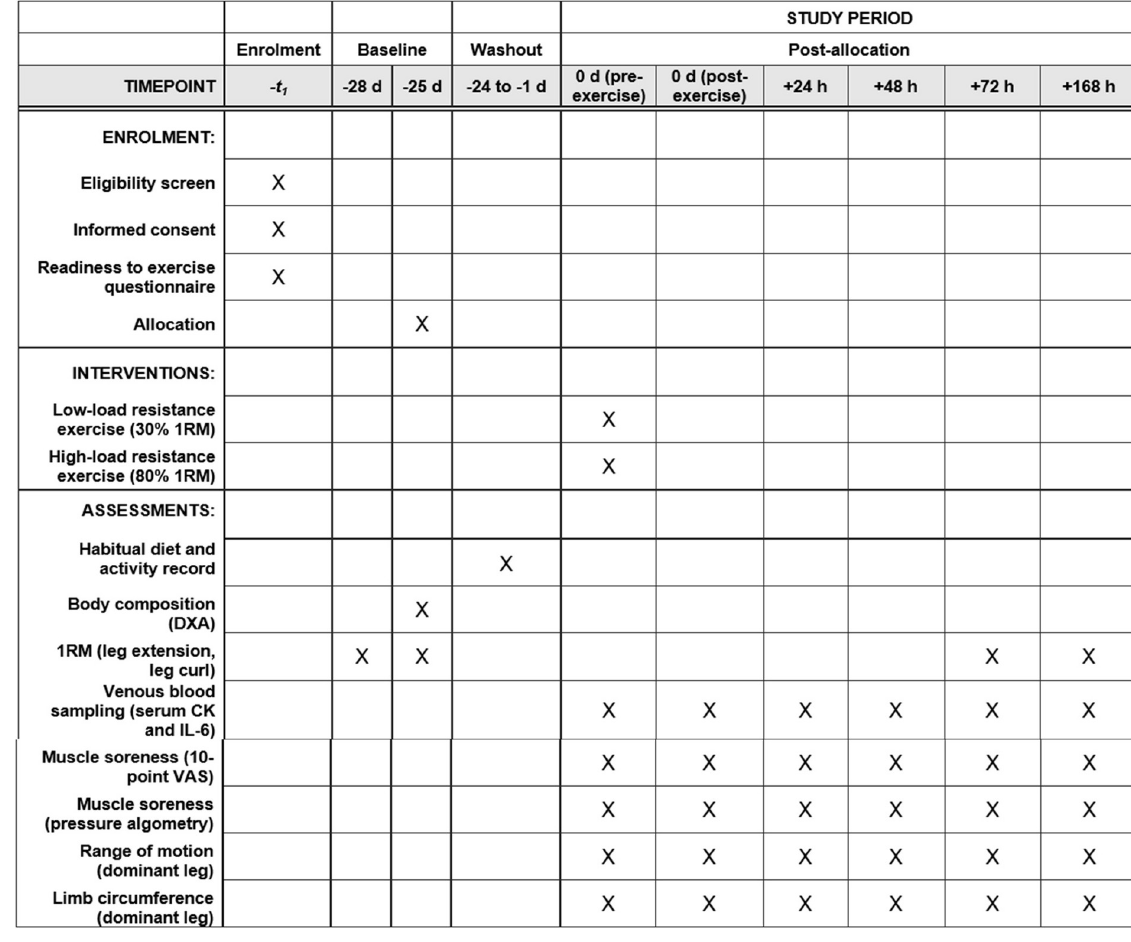
Fig 1. SPIRIT Schedule of enrolment, interventions, and assessments. 1RM = one repetition maximum; DXA = dual-energy X-ray absorptiometry; CK = creatine kinase; IL-6 = interleukin-6; VAS = visual analogue scale.